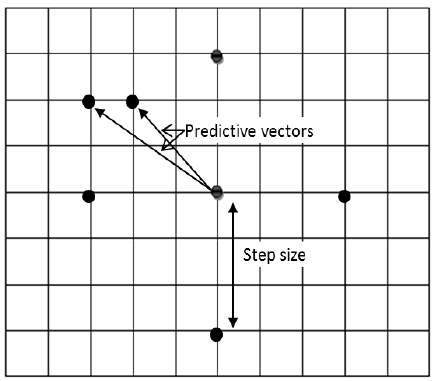
Figure 4. Mean predictive block matching algorithms for the MPBMLY algorithm, including the large search pattern (LSP) and two predictive vectors. Solid circle points ( • ) correspond to the search points.